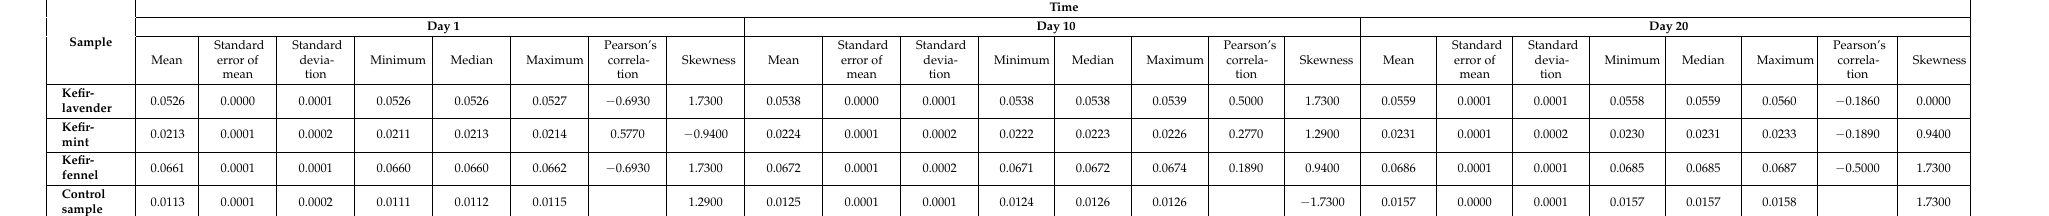
Table A4. Determination of L-glutamic acid content.